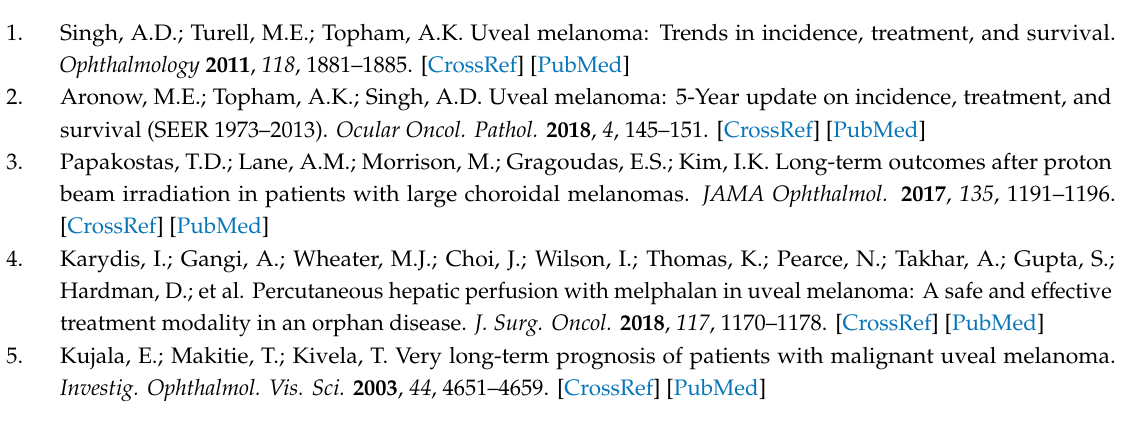
Figure S1: Overall Survival (OS) and PRKDC (DNA-PK) gene expression di ff erence between the cohorts of Monosomy 3 chromosome 8q gain (M3G8q, n = 47) and Disomy 3 (D3, n = 32) TCGA UM ( n = 79), Figure S2: UM are insensitive to PARP inhibition, Figure S3: Sensitisation of UM to IR / MMC by inhibition of DNA-PK, Table S1: Clinico-pathological details of UM short-term